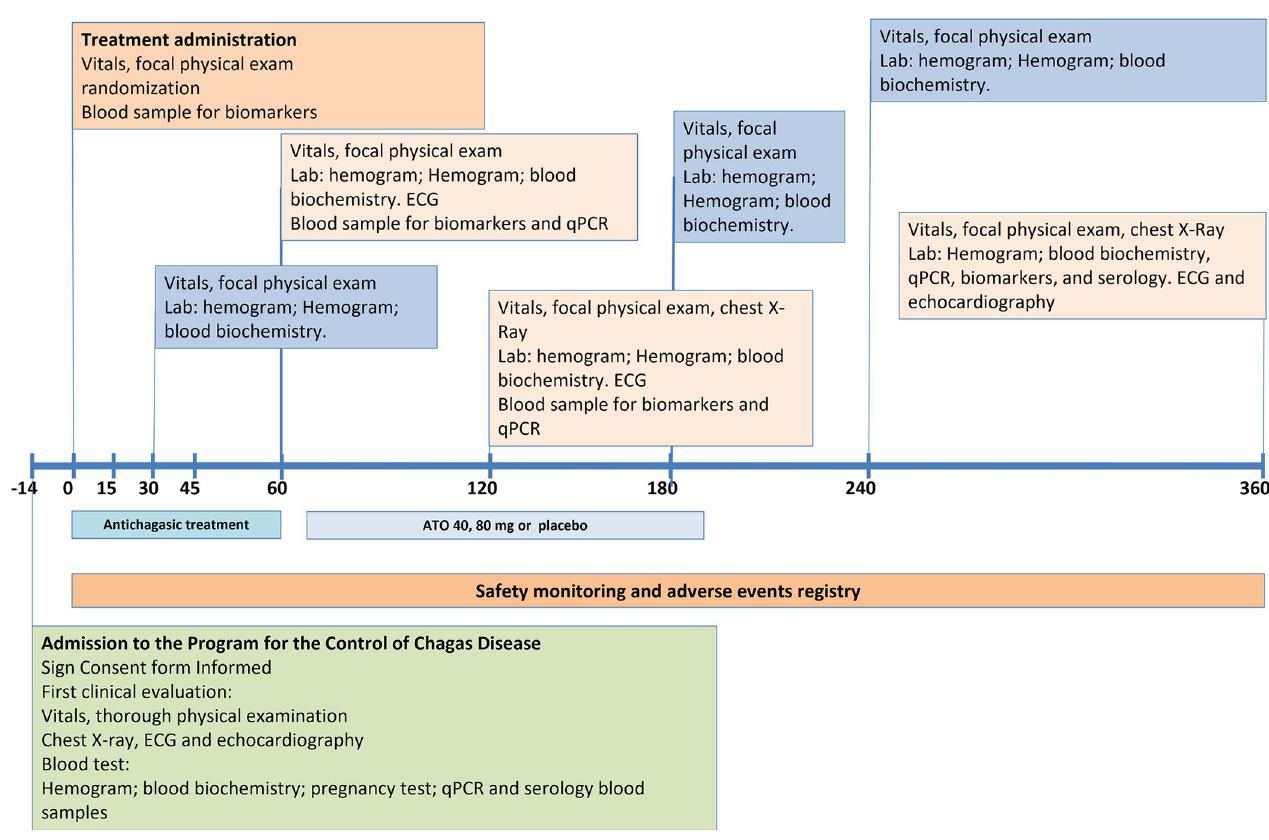
Fig 2. Graphic timeline of the main events in the